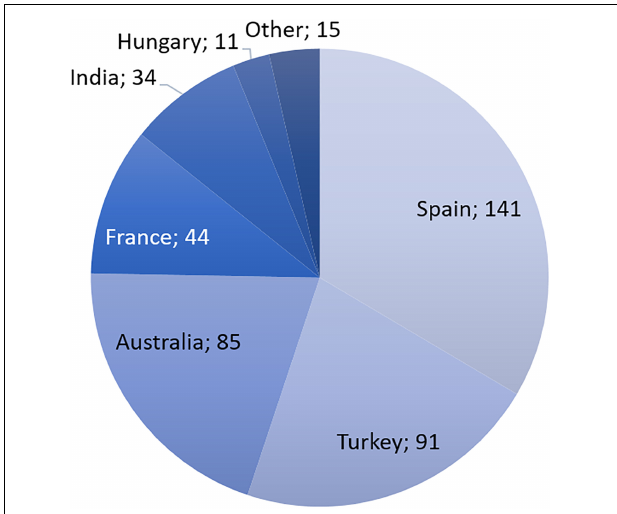
FIGURE 1 | Production of opiate raw materials rich in morphine in tons of morphine equivalent, 2019. Based on data from INCB technical report 2020.